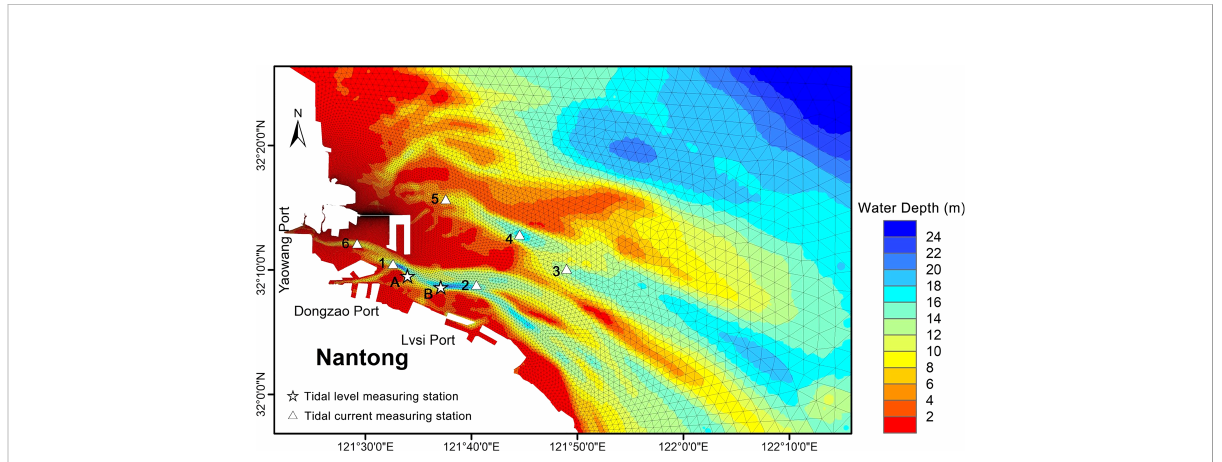
FIGURE 4 Model grid of study area, and locations of two tidal level measuring stations (A, B) and six tidal current measuring stations (1 – 6). The model grid is re fi ned in the nearshore waters, and the water depth in the surrounding waters is represented by a gradual change from red to blue. The map also identi fi es the names of adjacent ports and cities. In addition, the water depth corresponds to the National Vertical Datum